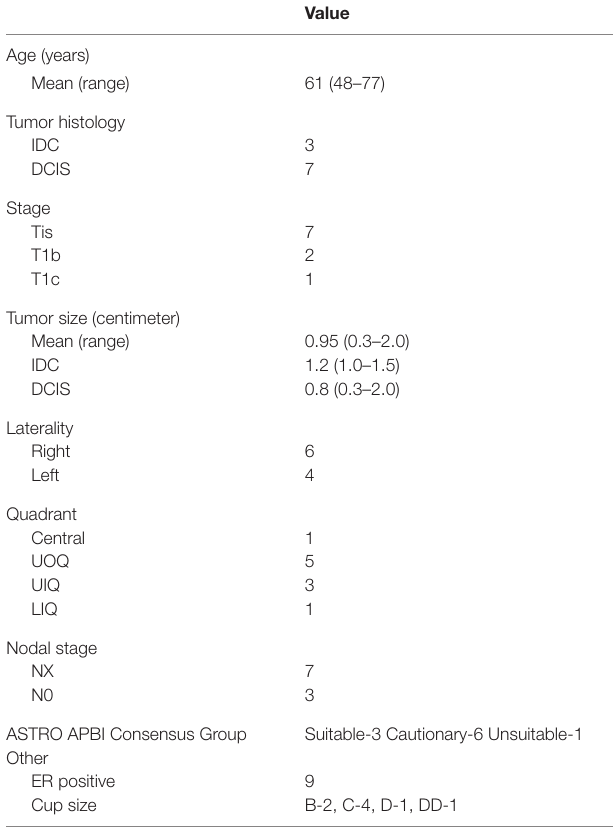
TaBle 1 | Patients and tumor